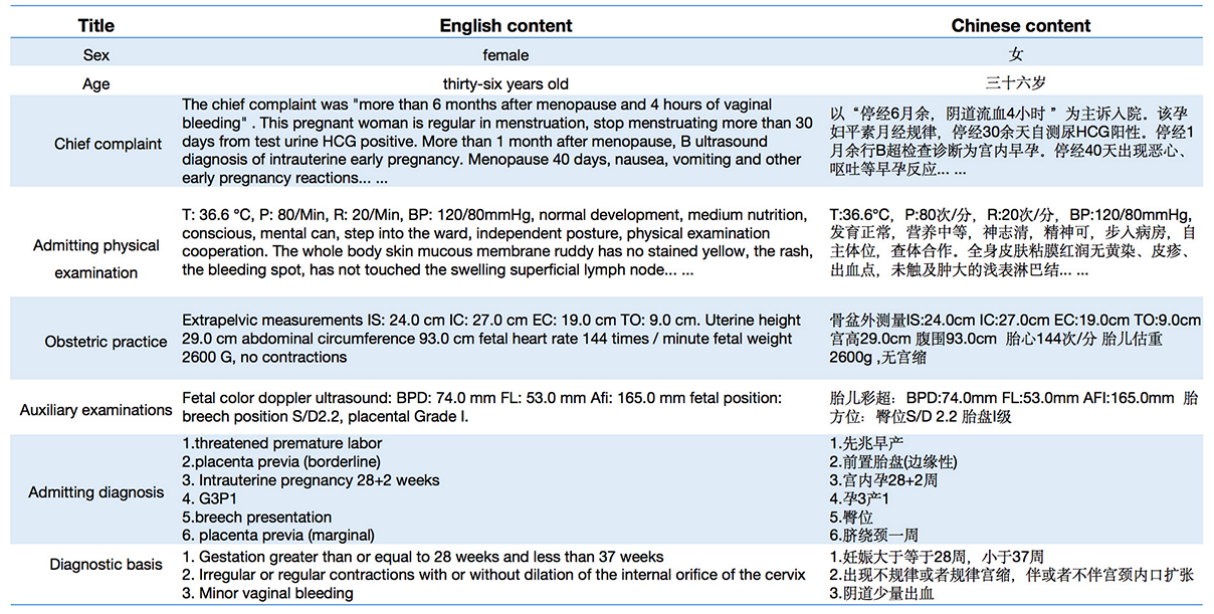
Figure 3. Chinese obstetric electronic medical record